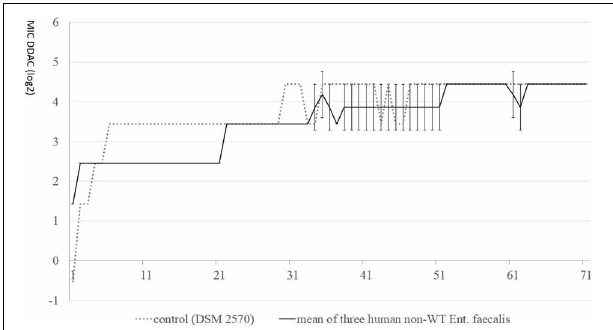
FIGURE 1 | MIC-values (log2) of didecyldimethylammoniumchloride (DDAC) in E. faecalis with initial MICs > 1.4mg/l, compared with control DSM 2570 during 70 days of stepwise adaptation.